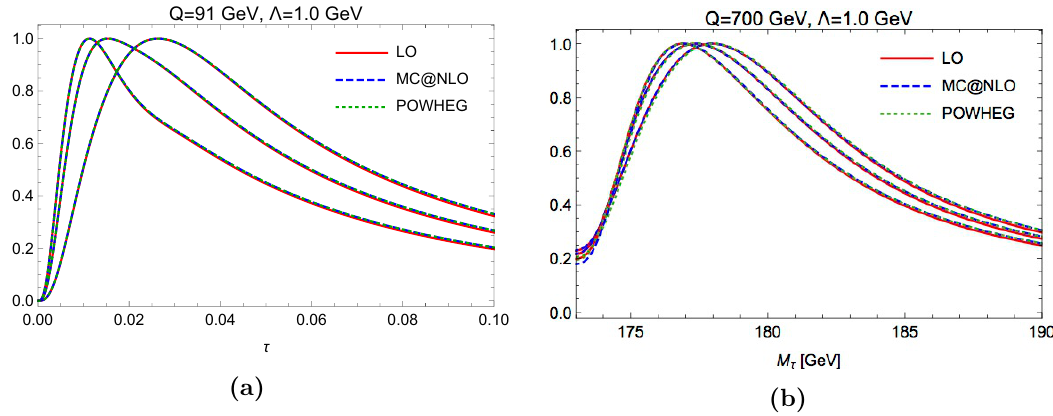
Figure 18. Thrust at the parton level in the peak region generated with Herwig 7 full simulations for (a) massless quarks at c.m. energy Q = 91 GeV and (b) top quarks with mass m t = 173 GeV at Q = 700 GeV. The parton level results are smeared with a soft model shape function with smearing parameter (cid:3) = 1 GeV, see section 2.3. Displayed are simulation results for shower cuts Q 0 = 1 : 0 GeV (right set of curves), Q 0 = 1 : 5 GeV (middle set of curves) and Q 0 = 2 GeV (left set of curves) at LO (i.e. without any NLO matching, solid red curves), with MC@NLO-type matching (dashed blue curves) and POWHEG-type matching (dotted green